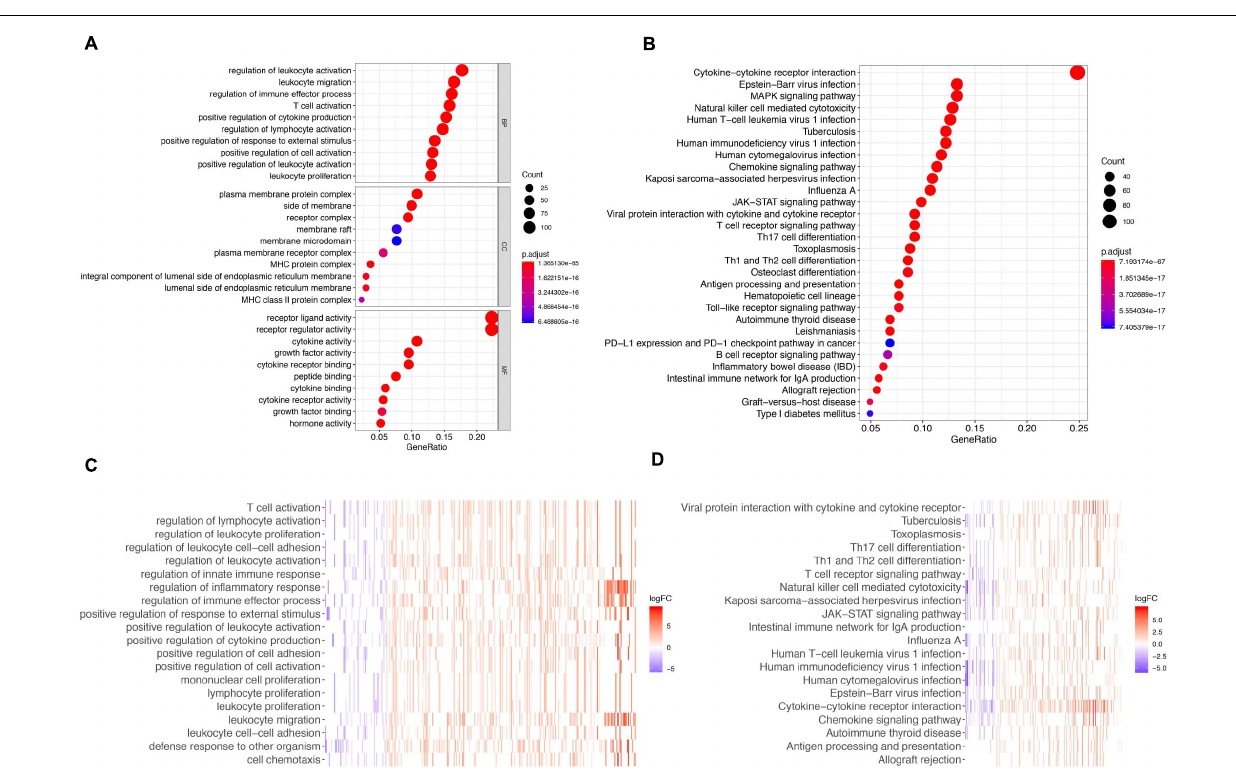
FIGURE 2 | GO terms and Enrichment of KEGG pathways for differentially expressed IRGs. (A) GO biological process analysis for the immune-related DEGs. (B) KEGG pathway enrichment analysis for the immune-related DEGs. (C) Heatmap of the GO terms by logFC. (D) Heatmap of the KEGG pathways by